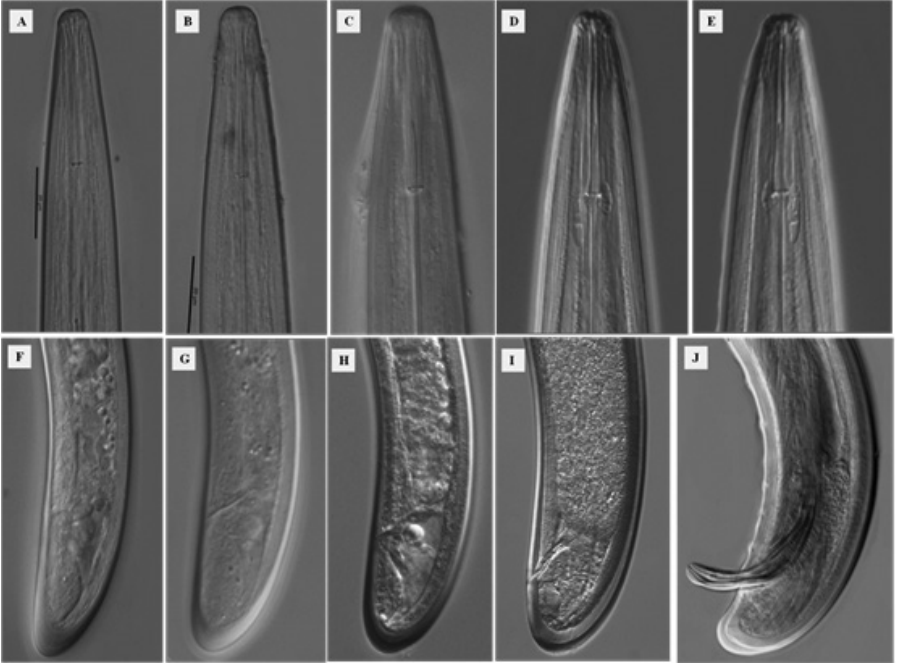
Figure 2. Longidorus cheni sp. n. Juveniles : A–C Head region of first-, second- and third-stage F–H Head region of first-, second- and third-stage. Female : D Head end I Tail end; Male : E Head end J Tail end. Scale bar: 20 μm ( A–J